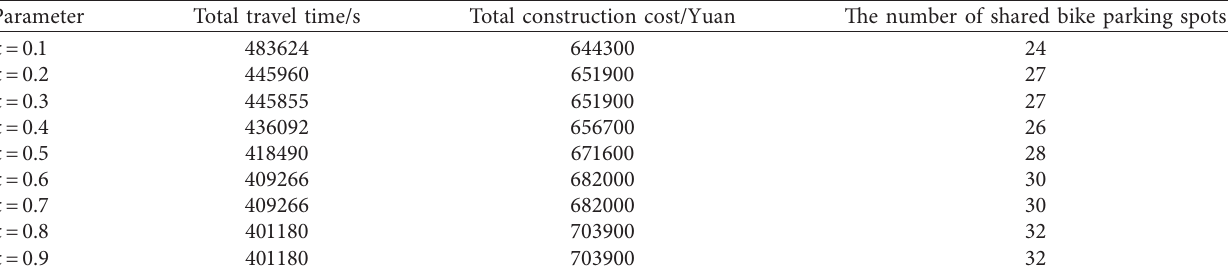
Table 6: The optimization result when k takes different